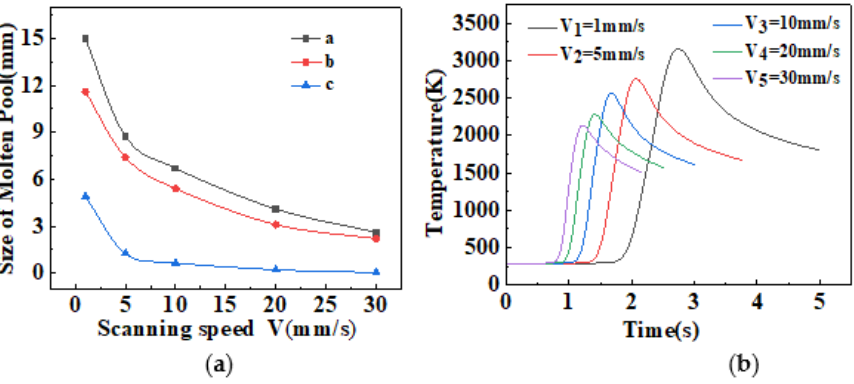
Figure 6. ( a ) Influence of laser moving speed on the molten pool morphology; ( b ) influence of laser moving speed on the peak temperature.